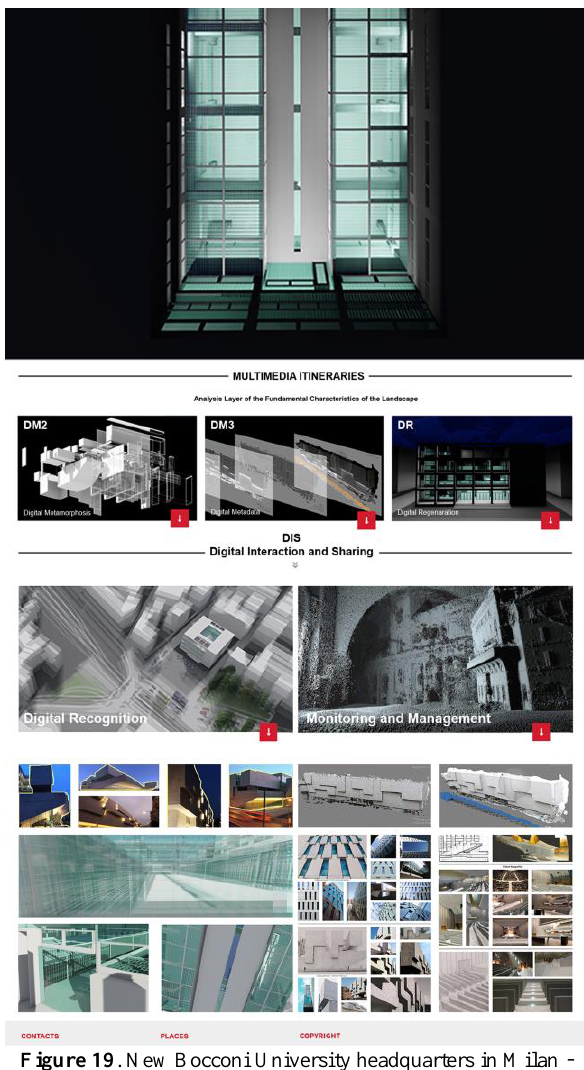
Figure 19 . New Bocconi University headquarters in Milan - Grafton building in via Röntgen (2008). Service integration host in the Cloud Computing Platform BIM/CHR (A. De